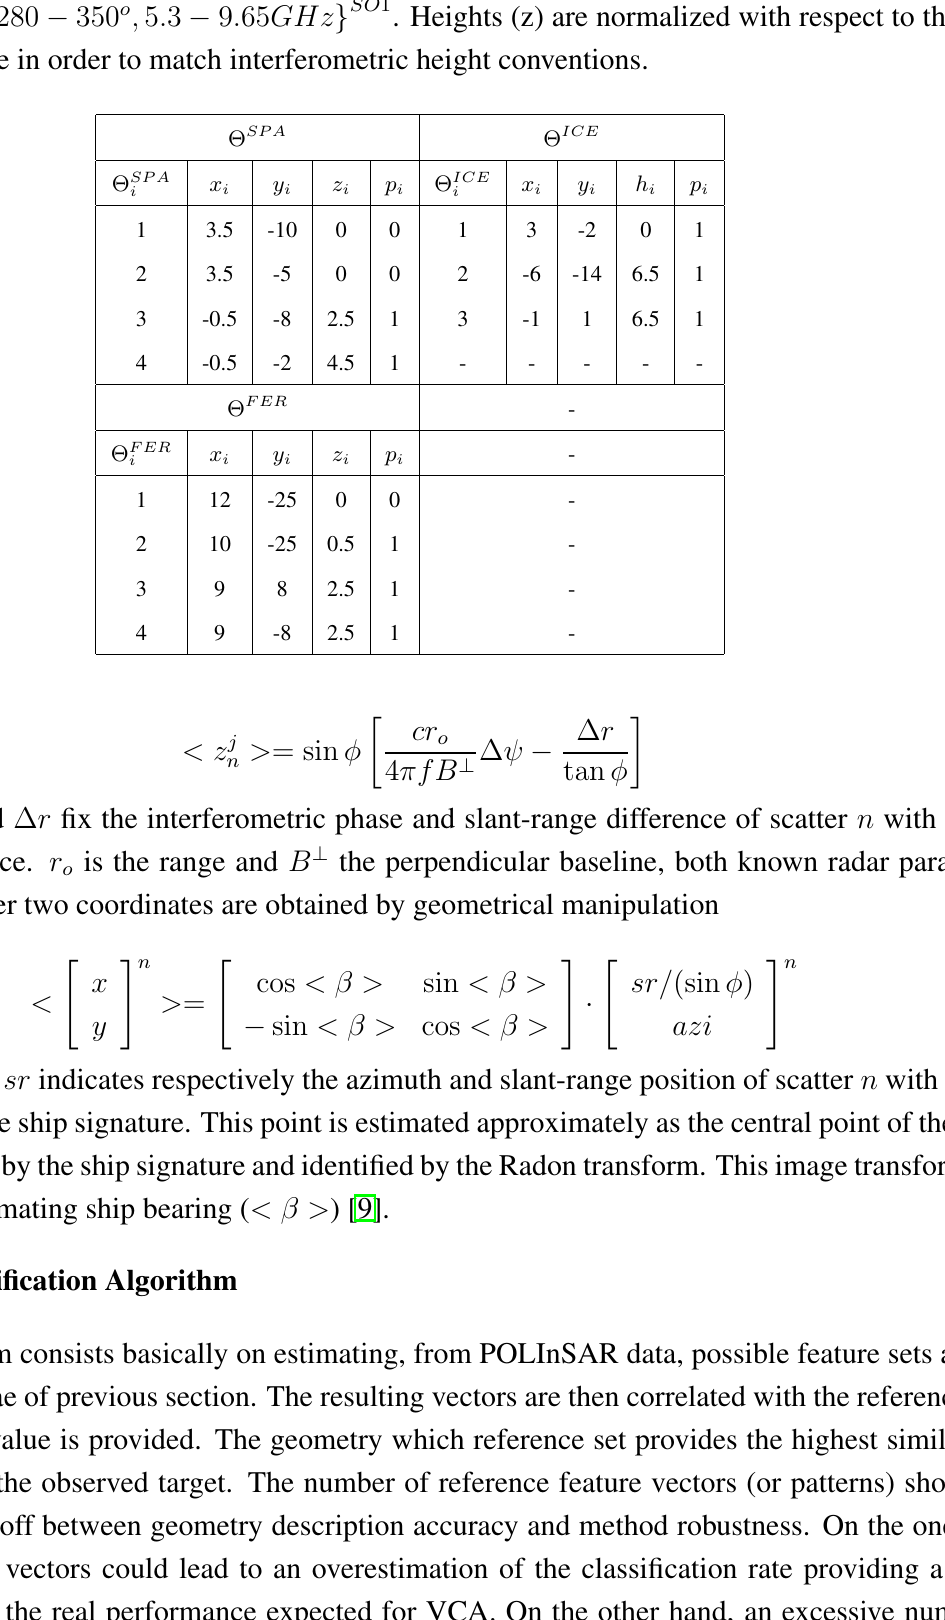
Table 1. Feature vectors for targets j = SP A , j = ICE and j = F ER and Φ SO 1